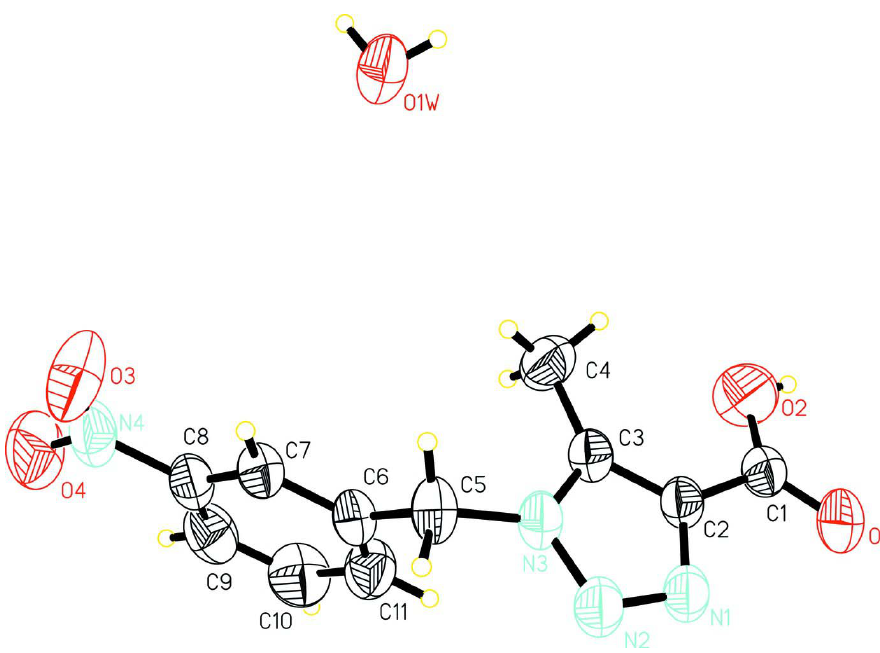
Figure 1 The molecular structure of (I), showing the atomic numbering scheme. Displacement ellipsoids are drawn at the 50% probability level.